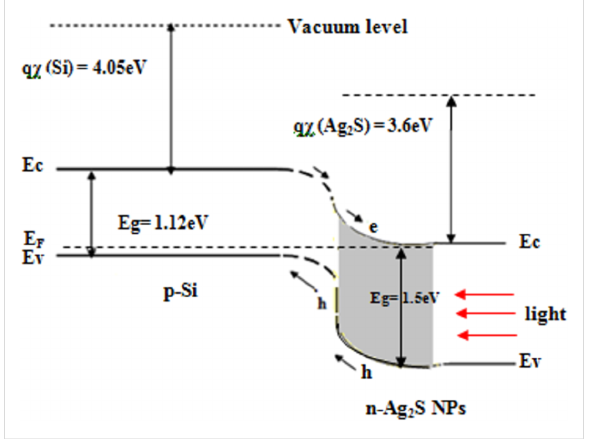
Figure 14: Illuminated energy band diagram of hybrid n-Ag 2 S NPs/p-Si